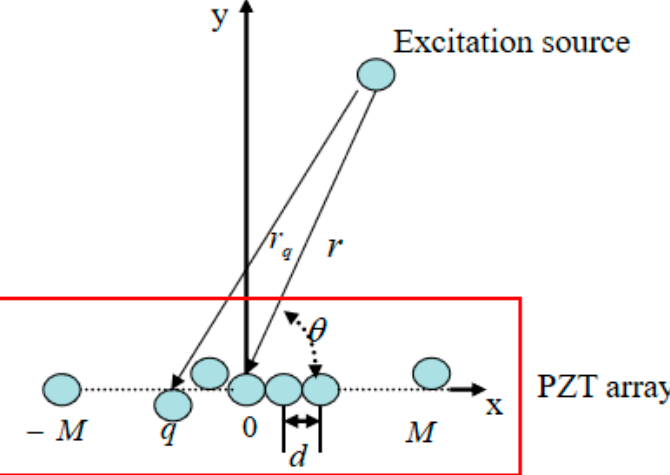
Figure 1. Array element position error schematic diagram.